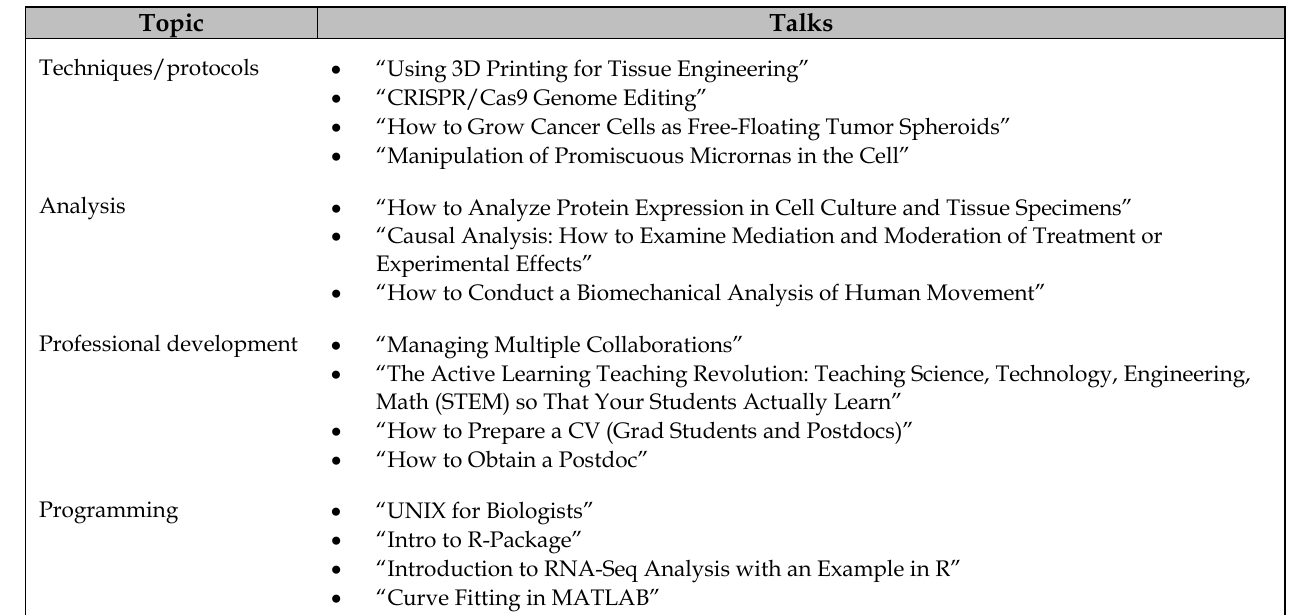
Table 1 Selection of talks included in the “How-to Talks by Postdocs” series Topic Talks